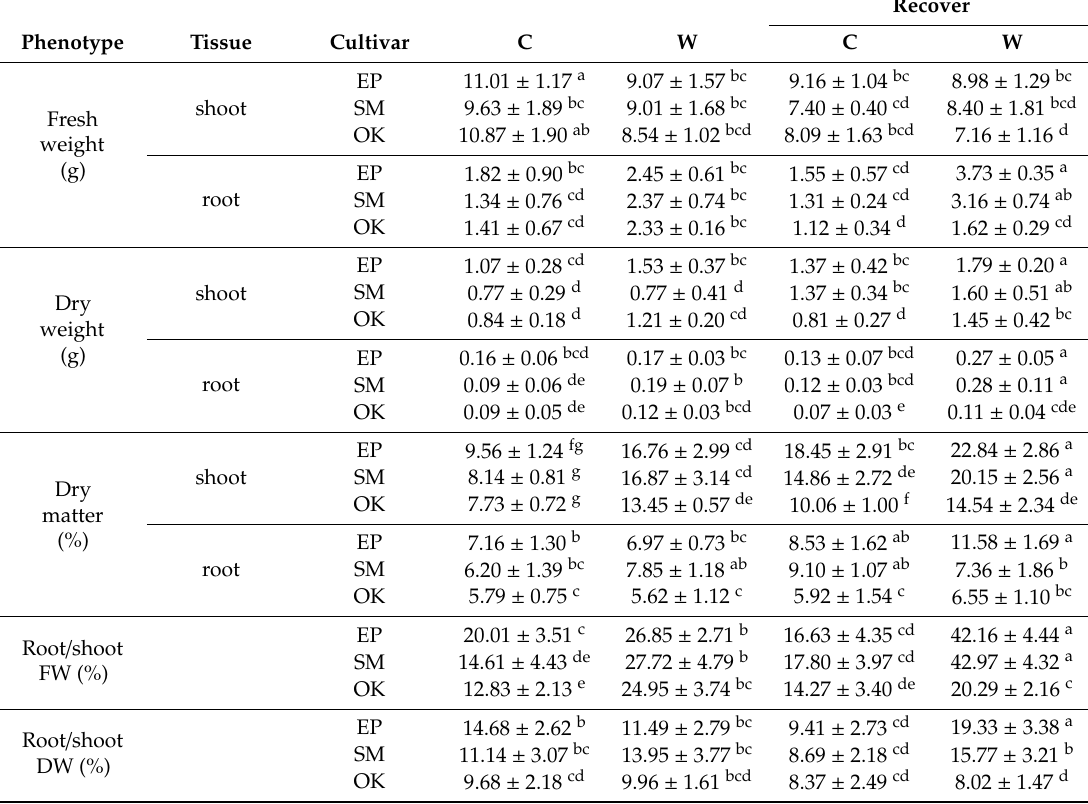
Table 1. Fresh weight, dry weight, and dry matter of shoots and roots, and root / shoot ratio of both fresh weight and dry weight in three squash cultivars ( Cucurbita moschata cv. Early Price (EP), Cucurbita (control, C) or waterlogging (W) for 13 days followed by drainage and recovery for 3